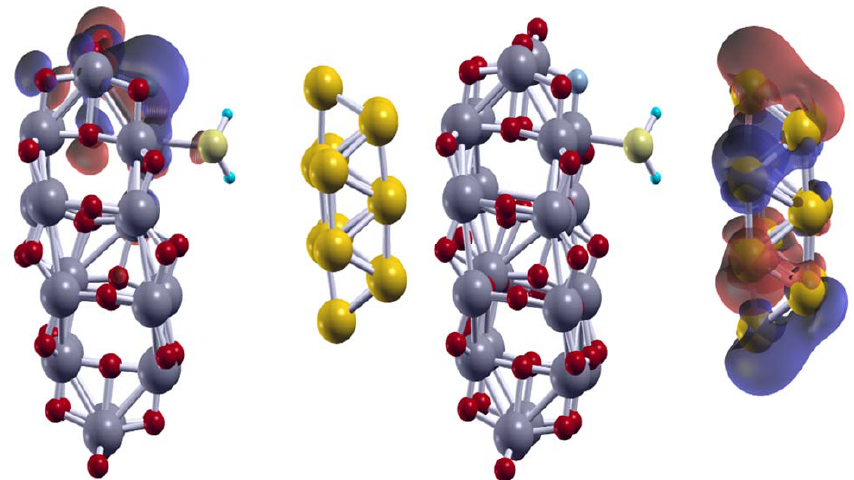
Fig. 6. The isosurfaces of HOMO and LUMO molecular orbitals for H